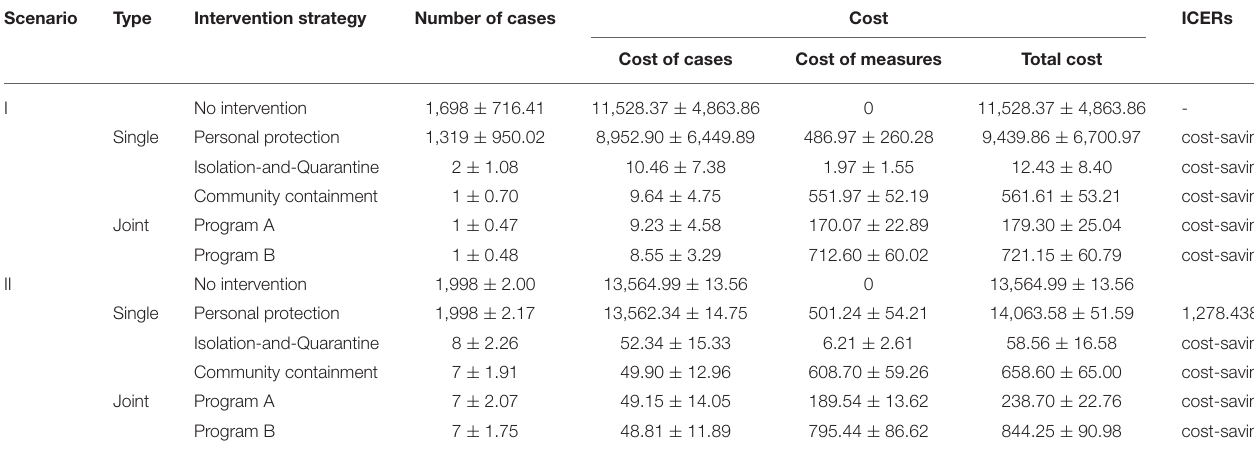
TABLE 2 | The cost-effectiveness of intervention measures in different scenario (US$1,000)*. Scenario